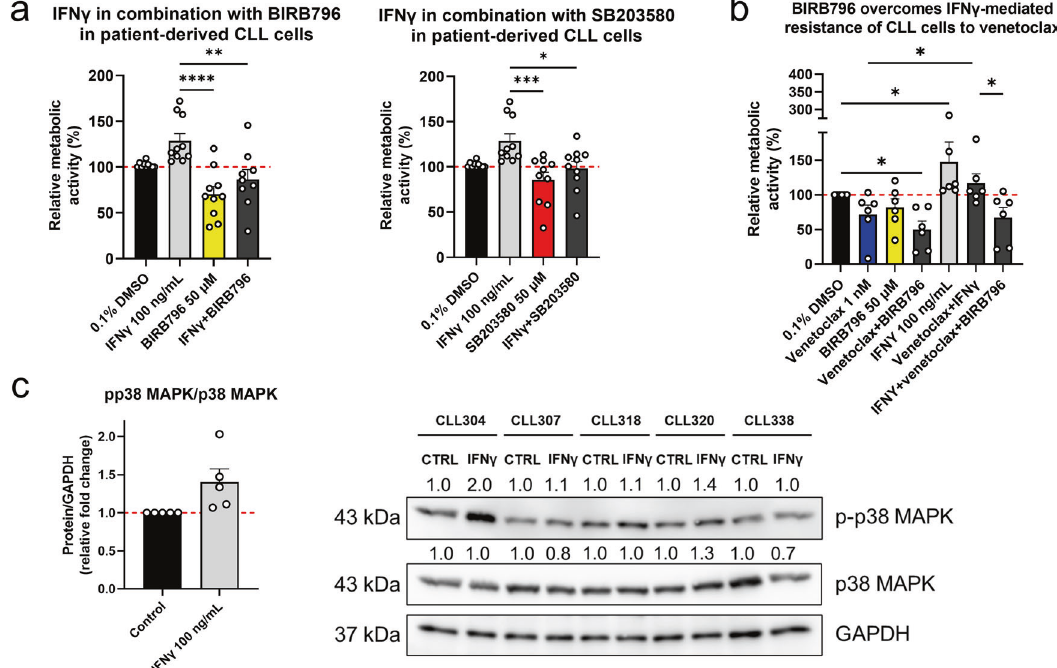
Fig. 5 Inhibition of p38 MAPK can reverse the cytoprotective effects of IFN γ . a Block on p38 MAPK pathway abolishes the stimulating effects of IFN γ in CLL cells. Primary cells (1 × 10 6 cells/mL) obtained from 10 patients with CLL were treated with 0.1% DMSO (vehicle control) and 100 ng/mL IFN γ alone and in combination with 50 µM BIRB796 or 50 µM SB203580 for 24 h. The metabolic activity of cells was determined using the PrestoBlue assay. Data are means ± SEM of ≥ three independent experiments, carried out in duplicate. One-way ANOVA (post